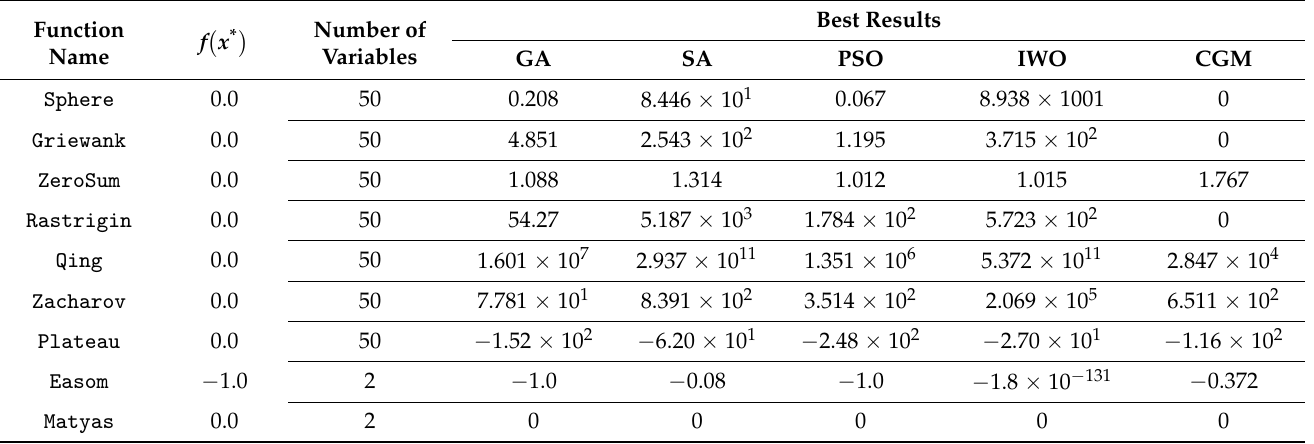
Table 3. The best results of different optimization algorithms for mathematical